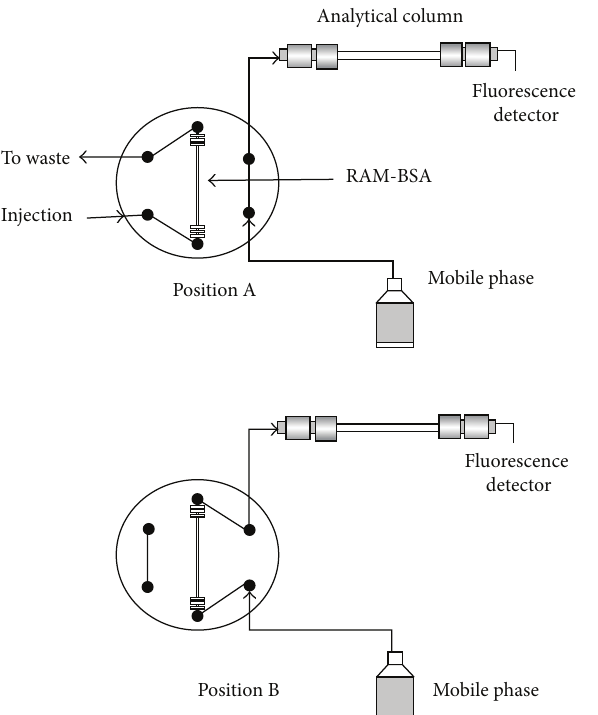
Figure 2: Scheme of the operation mode of the six-port switching valve in the RAM in-tube SPME developed method [76].